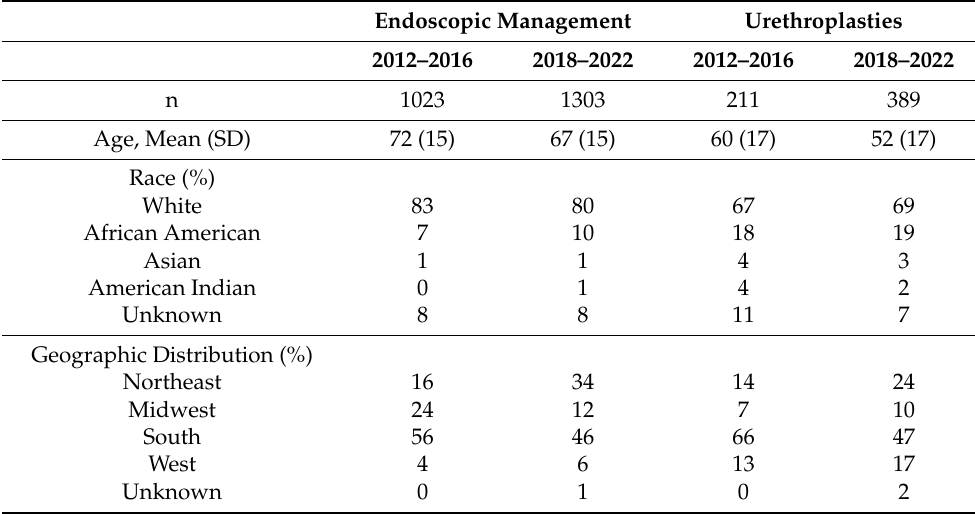
Table 3. Comparison of Female ≥ 18 Urethroplasty and Endoscopic management Procedures Cen- tered Around 2017 Guideline